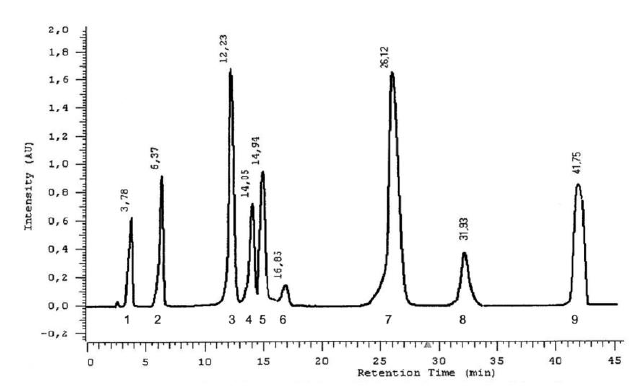
Figure 9. Separation of a mixture of phenolic acid standards in HPLC. Stationary phase—RP-18,